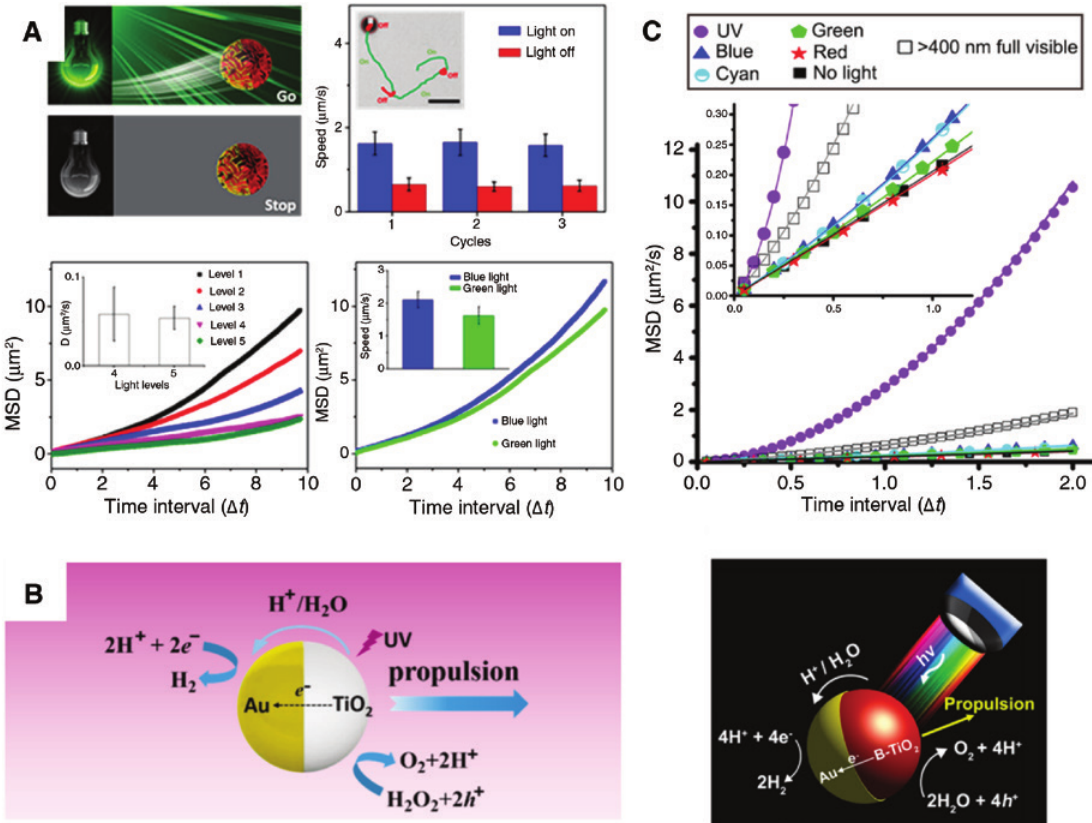
Figure 13: Light-driven micro/nanomotors actuated with UV and Vis light. (A) BiOI/Au micromotor actuated by Vis light. The “On/Off” control and the motion mean-square displacement for BiOI/Au micromotor are shown [72]. Copyright 2017, American Chemical Society. (B) Schematic illustrating the work mechanism of TiO /Au micromotor actuated by UV light [71]. Copyright 2015, American Chemical Society. 2 (C) Visible light-driven black-TiO /Au micromotor. Mean-square displacement and schematic of the work mechanism of the micromotor [117]. 2 Copyright 2017, American Chemical